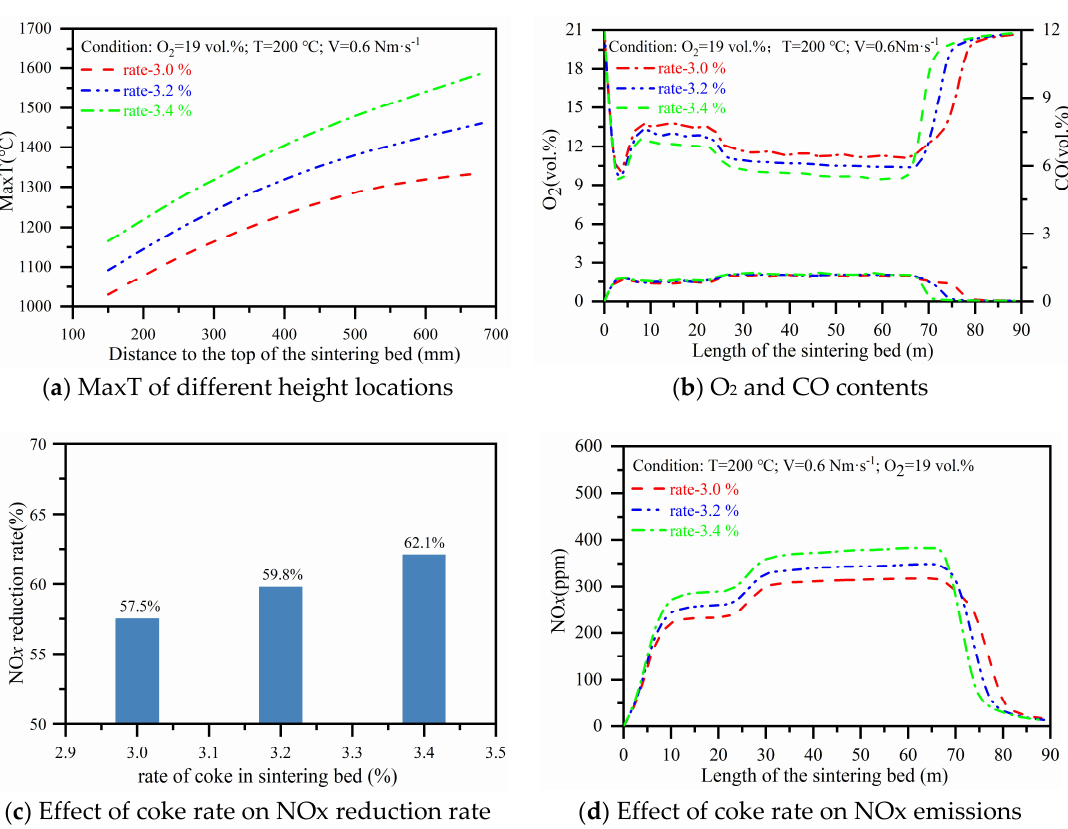
Figure 10. E ff ect of coke rate on NOx, CO, O 2 content in flue gas and MaxT (Maximum temperature).